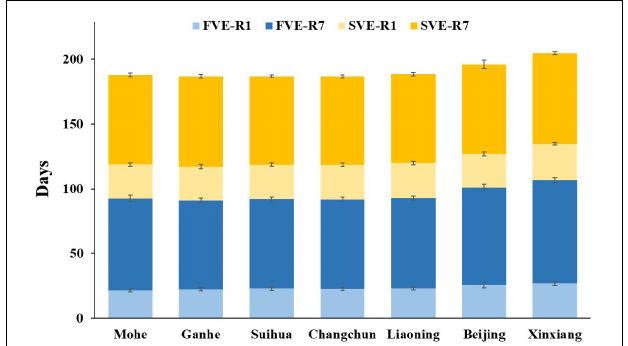
FIGURE 5 | Developmental stages of progenies of cross combinations from Northeastern Spring Planting Region and from Yellow–Huai–Hai Valleys Summer Planting Region planted in Hainan (Winter Nursery). F, first generation; S, subsequent generation; VE, emergence; R1, beginning bloom; R7, beginning